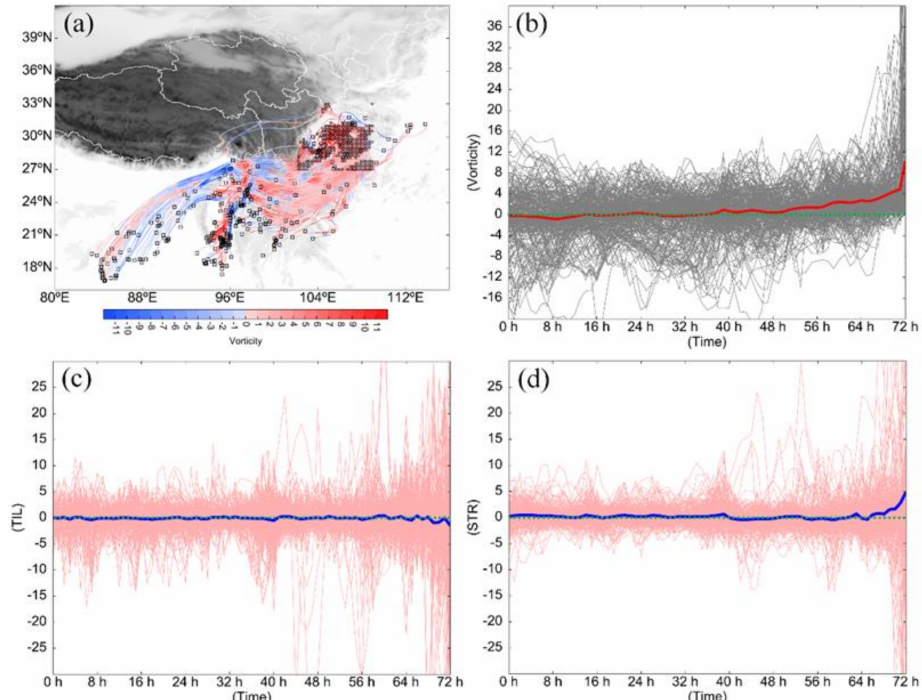
Figure 6. The same as Figure 5, but for the POS-LBE type trajectories. Panel ( a ) shows the backward (from 1800 UTC 26 to 1800 UTC 23 June 2020) trajectories and vorticity (shading, units: 10 − 5 s − 1 ) of the air particles that belong to the POS-LBE type, where black boxes/circles show the initial/final locations of the air particles. Panel ( b ) shows the vorticity variations of the POS-LBE-type trajectories (units: 10 − 6 s − 1 ). Panels ( c , d ) show the budget terms TIL and STR of the POS-LBE-type trajectories, respectively (units: 10 − 10 s − 2